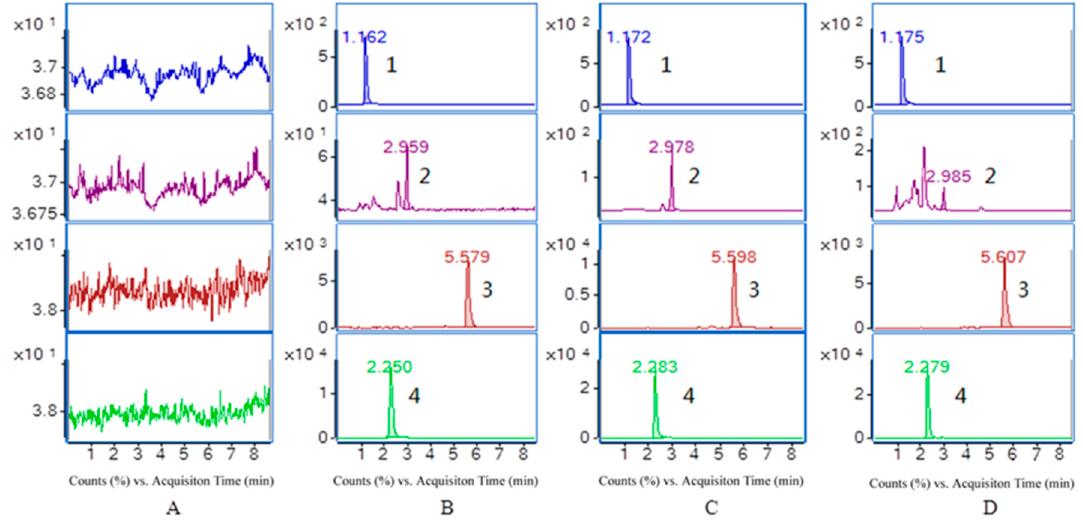
Figure 3. Representative MRM chromatograms of I.S. (1), mollugin (2), munjistin (3) and purpurin (4) in rat plasma ( A ) a blank sample (without the three analytes and I.S.); ( B ) LLOQ sample (three analytes and I.S.); ( C ) QC sample (three analytes and I.S.) and ( D ) a rat sample taken 2 h after administration of 0.82 g/kg R. cordifolia .